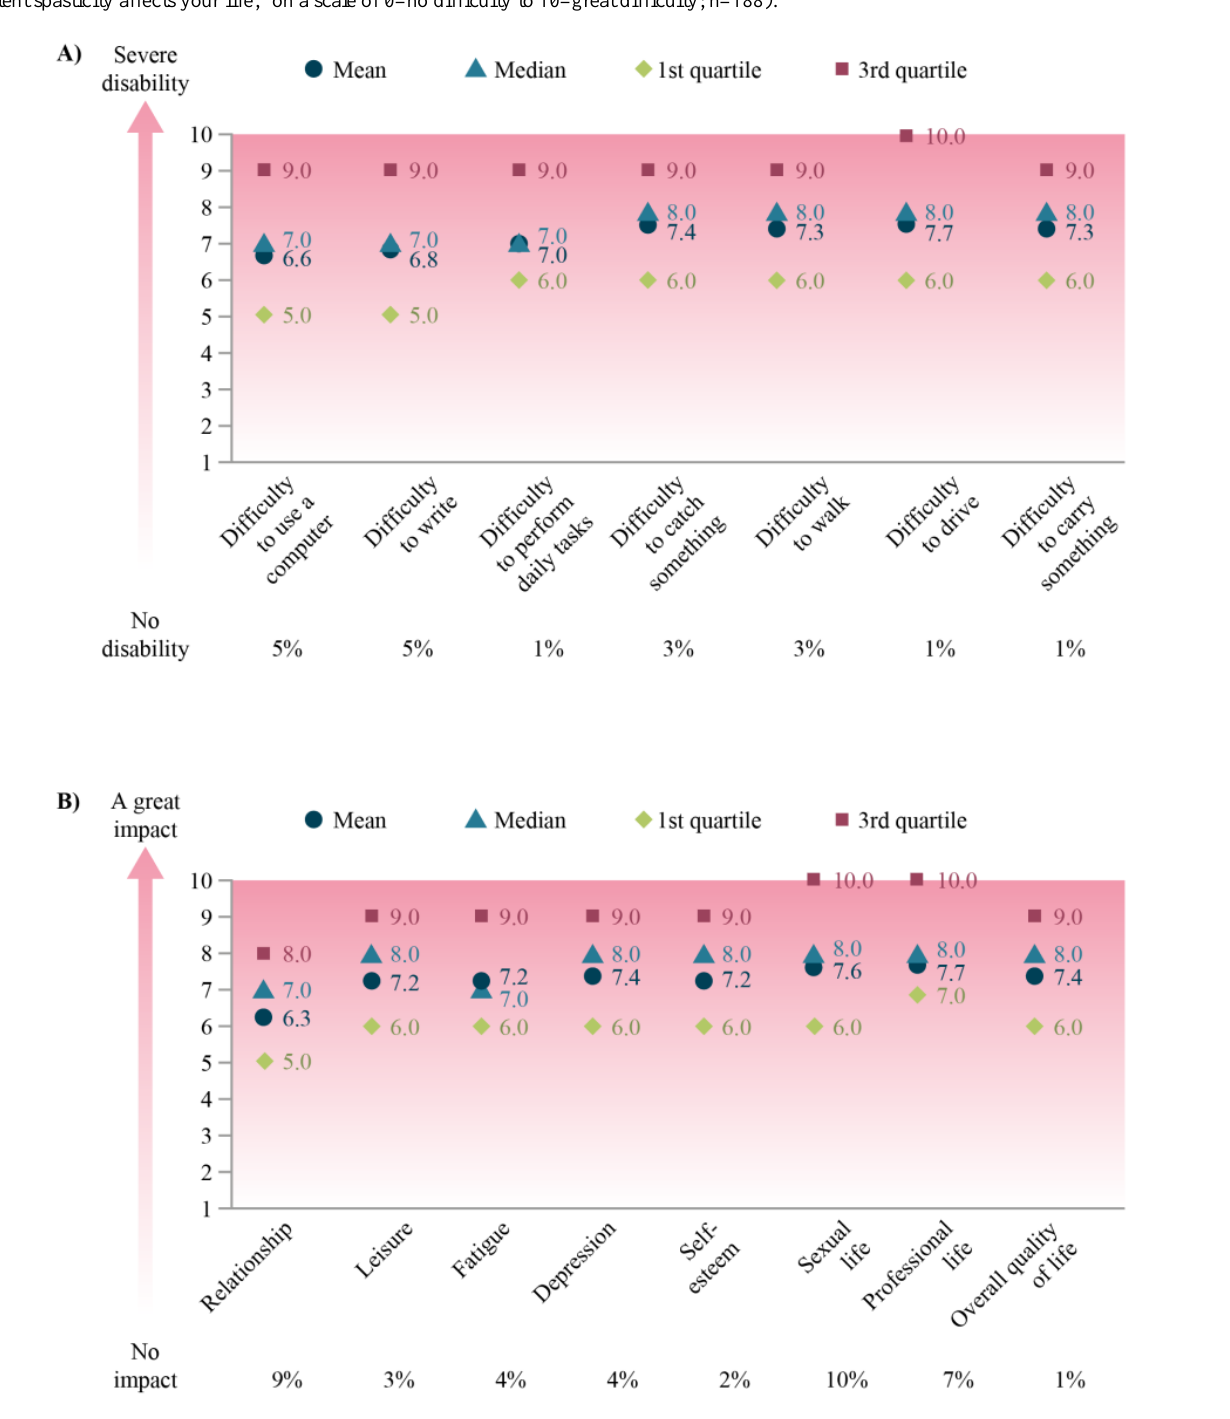
Figure 3. Caregiver responses on the impact of spasticity on the patients’ (A) daily life ("For each of the following items, please assess the level of difficulty you experience due to your spasticity," on a scale of 0=no disability to 10=severe disability) and (B) quality of life ("Please assess to